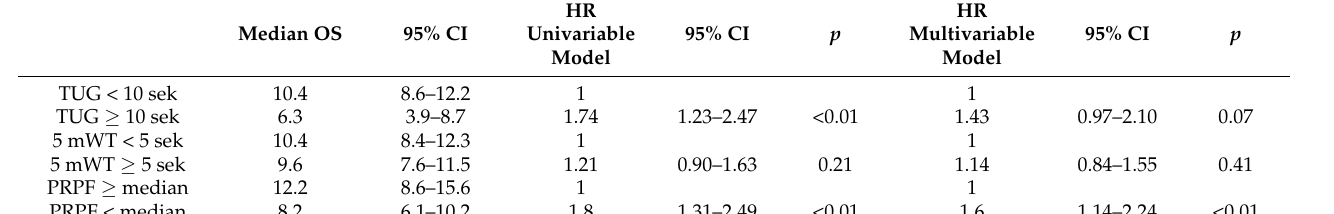
Table 3. Differences in survival according to cutoff values for measured and patient-reported physi- cal function.